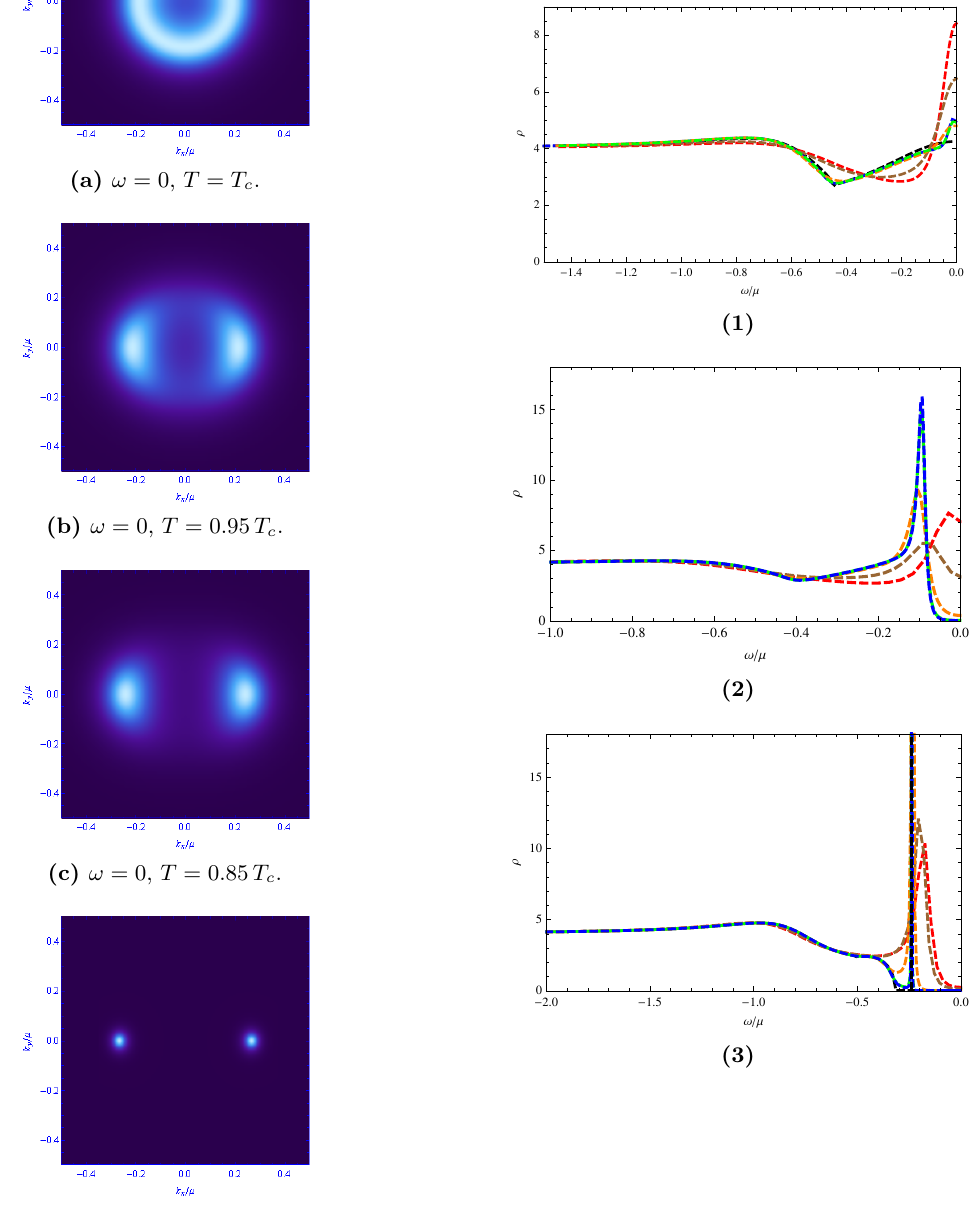
Figure 14. The spectral function at (cid:12)xed (cid:21) = 0 : 40 < (cid:21) c . Left: the spectral surface ! = 0 at di(cid:11)erent temperatures. Right: (1) (cid:26) as a function of ! at ( k x ; k y ) = ( k (cid:3) ; 0), notice that the black curve ( T = 0) also presents a delta-like peak at ! = 0 which is not depicted in the (cid:12)gure; (2) (cid:26) as a function of ! at ( k x ; k y ) = (0 : 20 ; 0 : 10) (cid:22) ; (3) (cid:26) as a function of ! at ( k x ; k y ) = (0 : 20 ; 0 : 40) (cid:22) . Each graph in these plots corresponds to the temperatures: T = T c (red), T = 0 : 97 T c (brown), T = 0 : 86 T c (orange), T = 0 : 43 T c (green), T = 0 : 21 T c (blue), T = 0 (black).